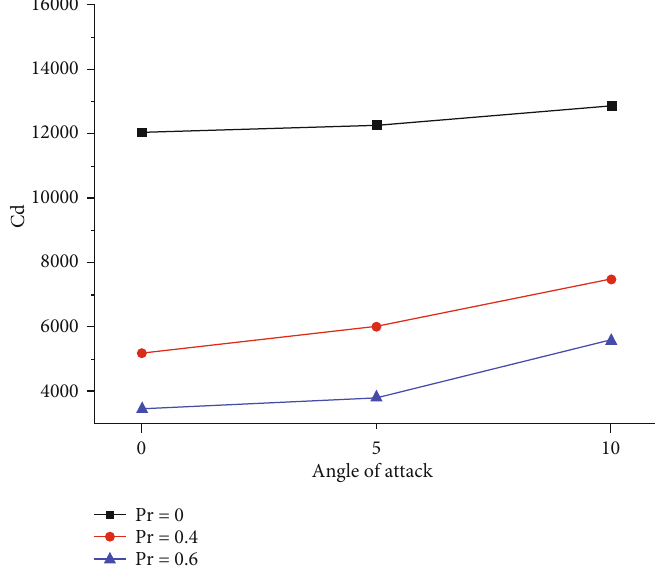
Pr = 0 Pr = 0.4 Figure 11: Resistance coe ffi cient changes with the angle of attack at di ff erent pressure